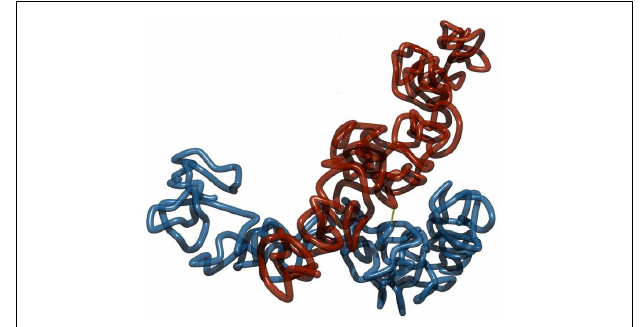
FIGURE 5 | Two sister chromatids with a permanent link at the middle and no links otherwise. The single link at the middle holds model sister chromatids together. However, without further links at the arms, the entropic repulsive forces between the folded fibers makes it unfavorable for them to align in parallel to each other. Instead, a more cross-like conformation is